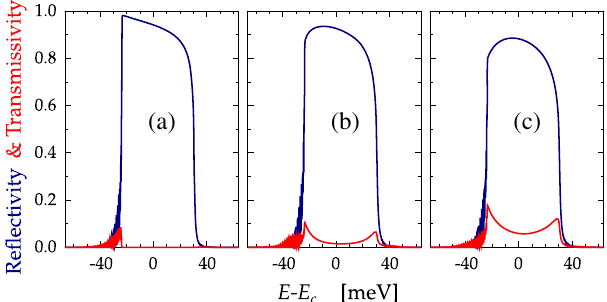
FIG. 2. Spectral reflection profiles (blue) of the four-crystal perfectly aligned empty cavity (see Fig. 1) as a result of four successive (400) Bragg reflections of x-rays from diamond crystals B → C → D → A. The transmission profile through crystal A is shown in red. Crystals B, C, and D have a thickness of 300 μ m, while crystal A ’ s thickness is (a) 300 μ m, (b) 20 μ m, and (c) 15 μ m, respectively. Photon energy E angular spread (FWHM) of x-rays — 2 . 5 μ rad, Bragg ’ s angle θ ¼